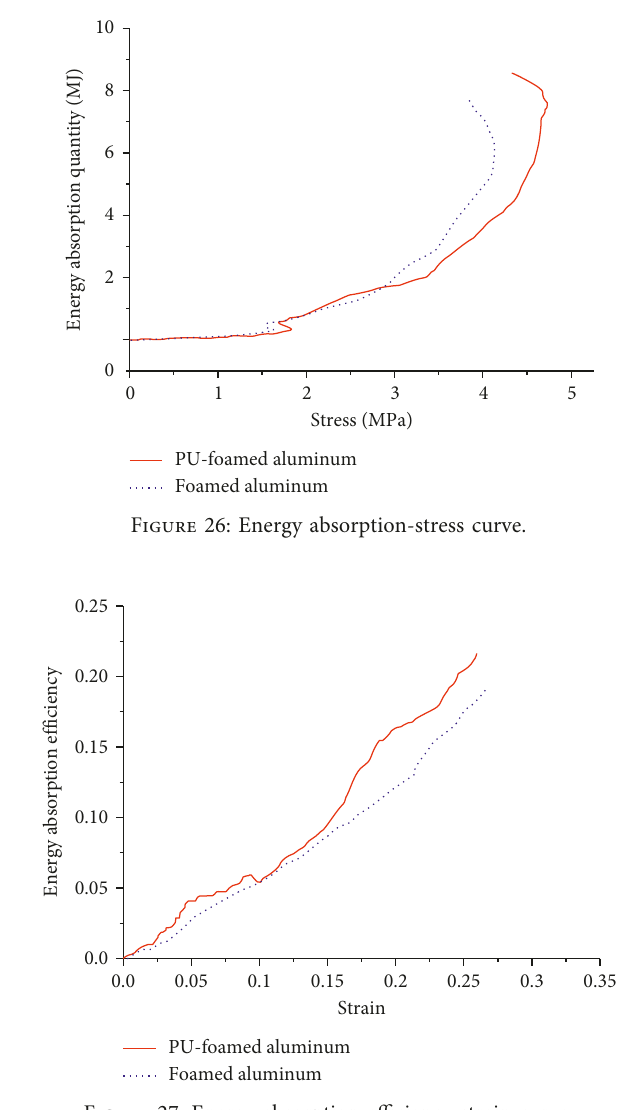
Figure 27: Energy absorption efficiency-strain